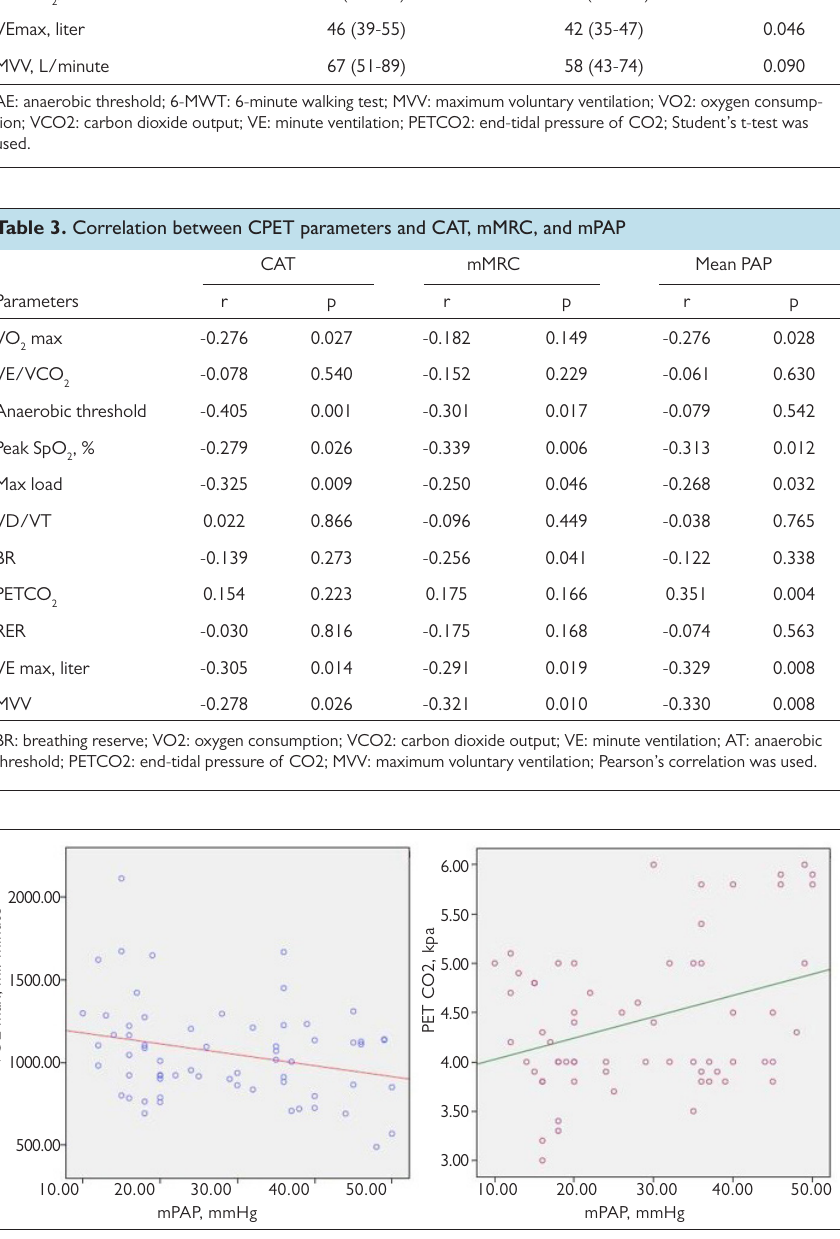
Figure 1. Correlations Between VO2max, PETCO2, and